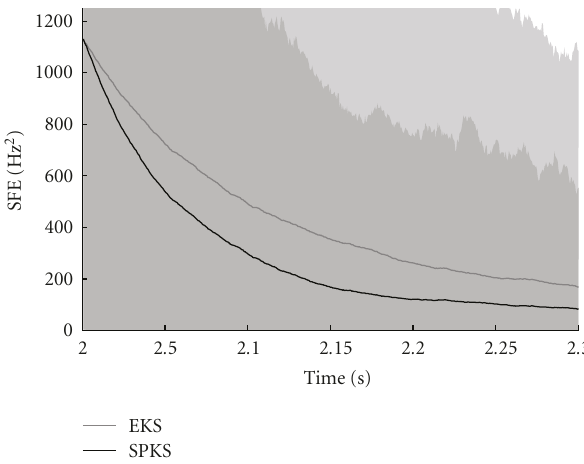
Figure 4: Convergence Speed (SFE( n ) versus Time) at SNR = − 3. In this figure the shaded regions represent the 5th and 95th percentile ranges of the SFE( n